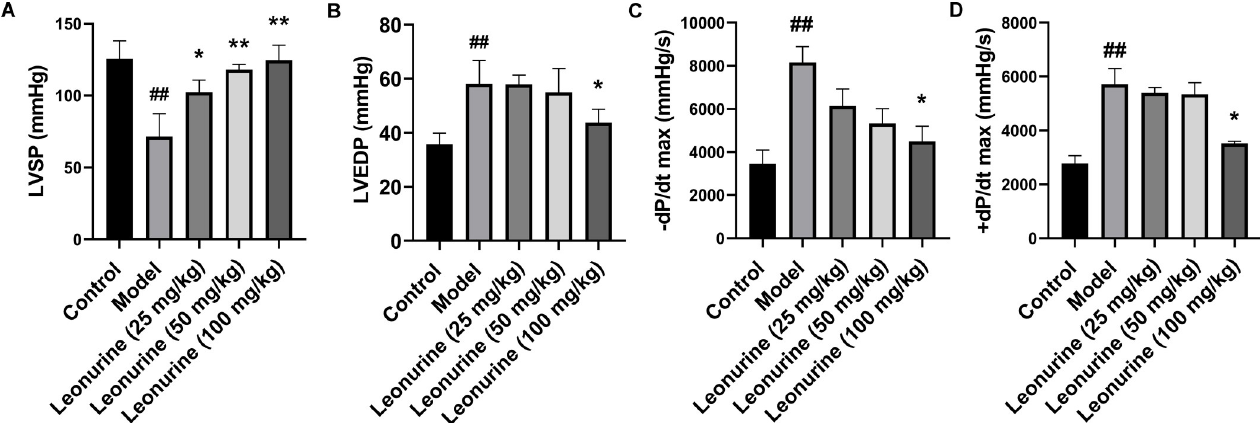
Fig 1. Leonurine enhanced cardiac function in rats with ISO-induced heart failure by improving haemodynamic variables. Cardiac function is responsive to haemodynamic variables, including LVSP, LVEDP, -dP/dt max, and +dP/dt max. Leonurine increased (A) LVSP level, and decreased levels of (B) LVEDP, (C) -dP/dt max, and (D) +dP/dt max compared with the model group. ##P < 0.01, control group vs. model group; �� P < 0.01, � P < 0.05, leonurine groups vs. model group. LVSP, left ventricular systolic pressure; LVEDP, left ventricular end-diastolic pressure; -dP/dt max, the falling rate of LVEDP; +dP/dt max, the rising rate of LVEDP.